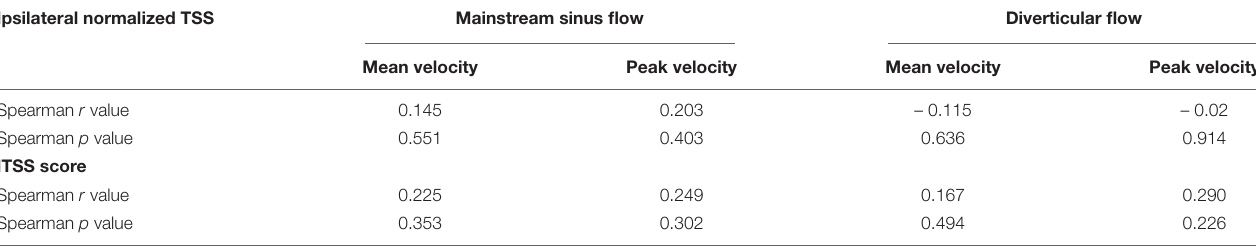
TABLE 3 | Results of correlation analysis between hemodynamics and transverse sinus stenosis.